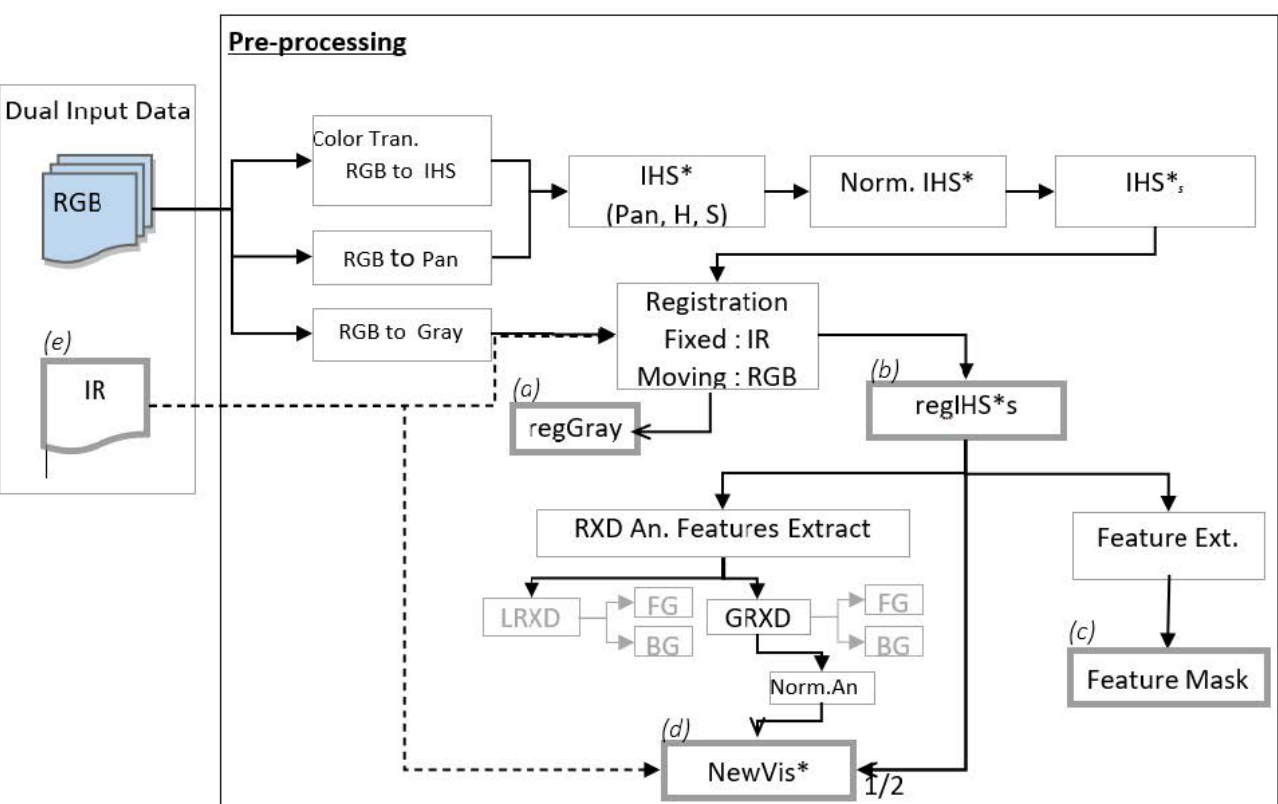
Figure 3. Schema of the proposed pre-processing workflow. Final products of the pre-processing phase are a registered grey representation of an RGB image ( a ), a registered saturation layer of an IHS image ( b ), a feature mask based on the ( b ) layer ( c ), and a new visual image representation ( d ) constructed from the integration of ( b ), RXD-based global anomaly of ( b ) and IR image ( e ). Color Transformation